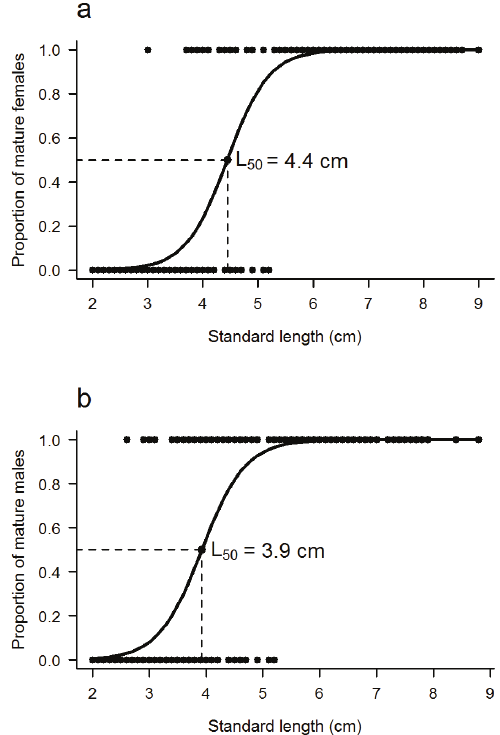
Figure 2 - Logistic regression curves for determination of the mean size of first maturation for females ( a ) and males ( b ) of Astyanax intermedius in Ribeirão Grande stream.